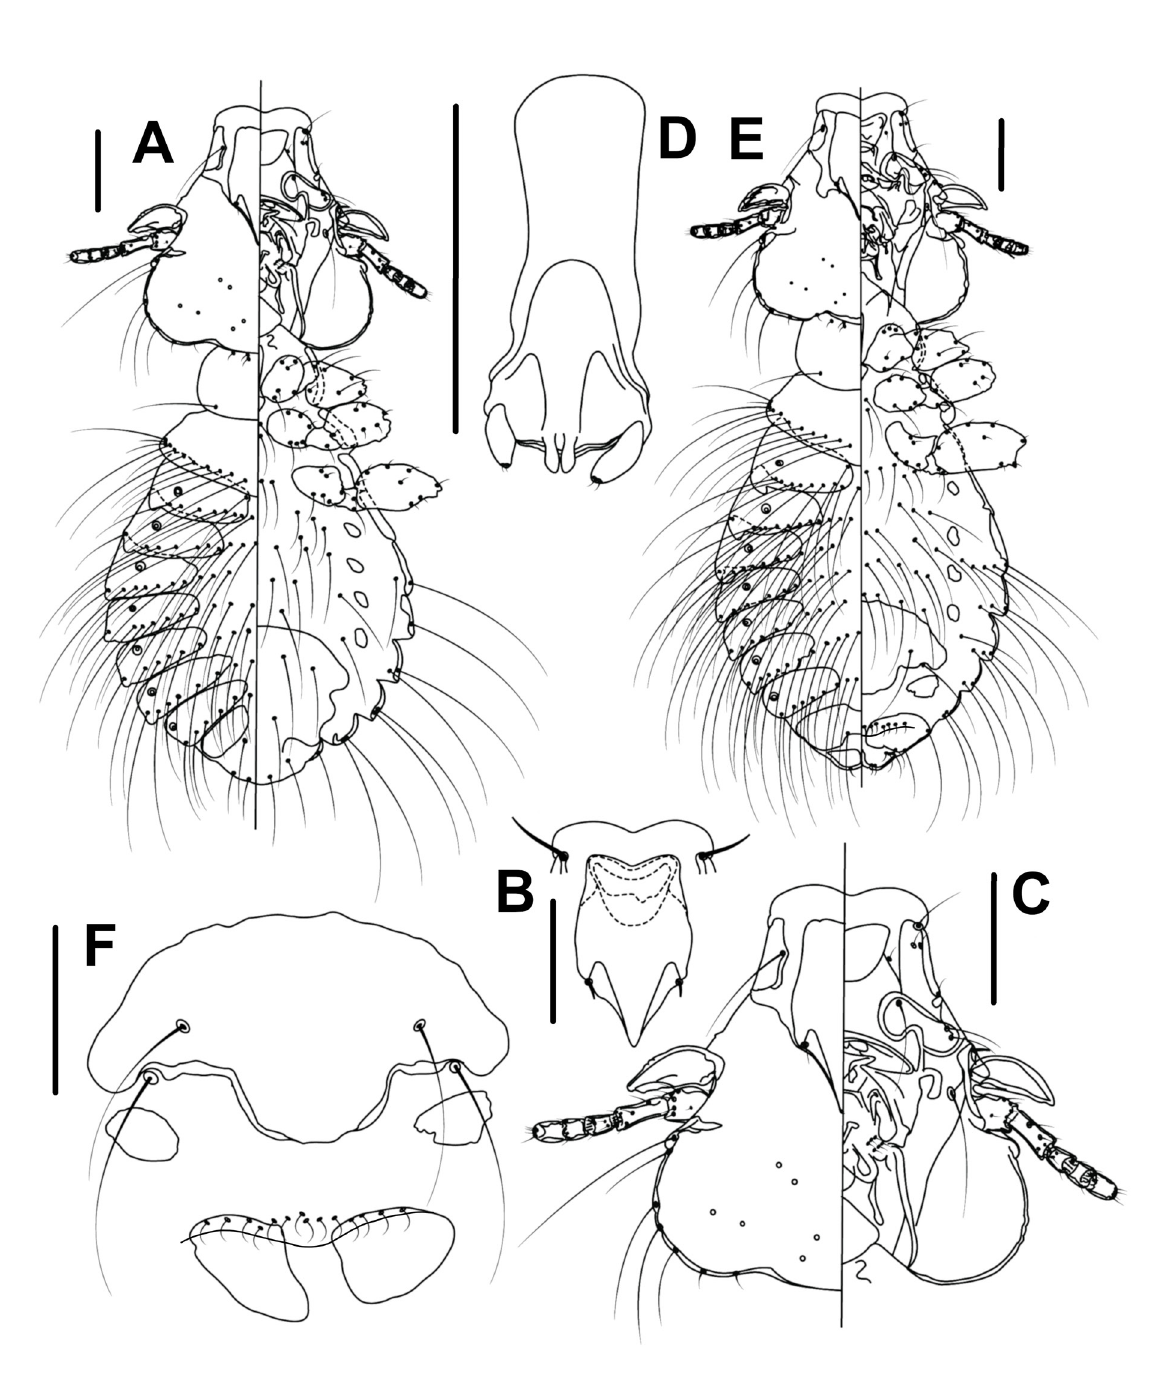
Fig. 4. Philopterus acrocephalus Carriker, 1949 ex Acrocephalus melanopogon (SK25 in MMBC). A . Male habitus, dorsal and ventral views. B . Male dorsal anterior plate (ADP), dorsal view. C . Male head, dorsal and ventral views. D . Male genitalia, ventral view. E . Female habitus, dorsal and ventral views. F . Female subgenital plate, vulval margin and ventral terminalia, ventral view. Scale bars: 0.1